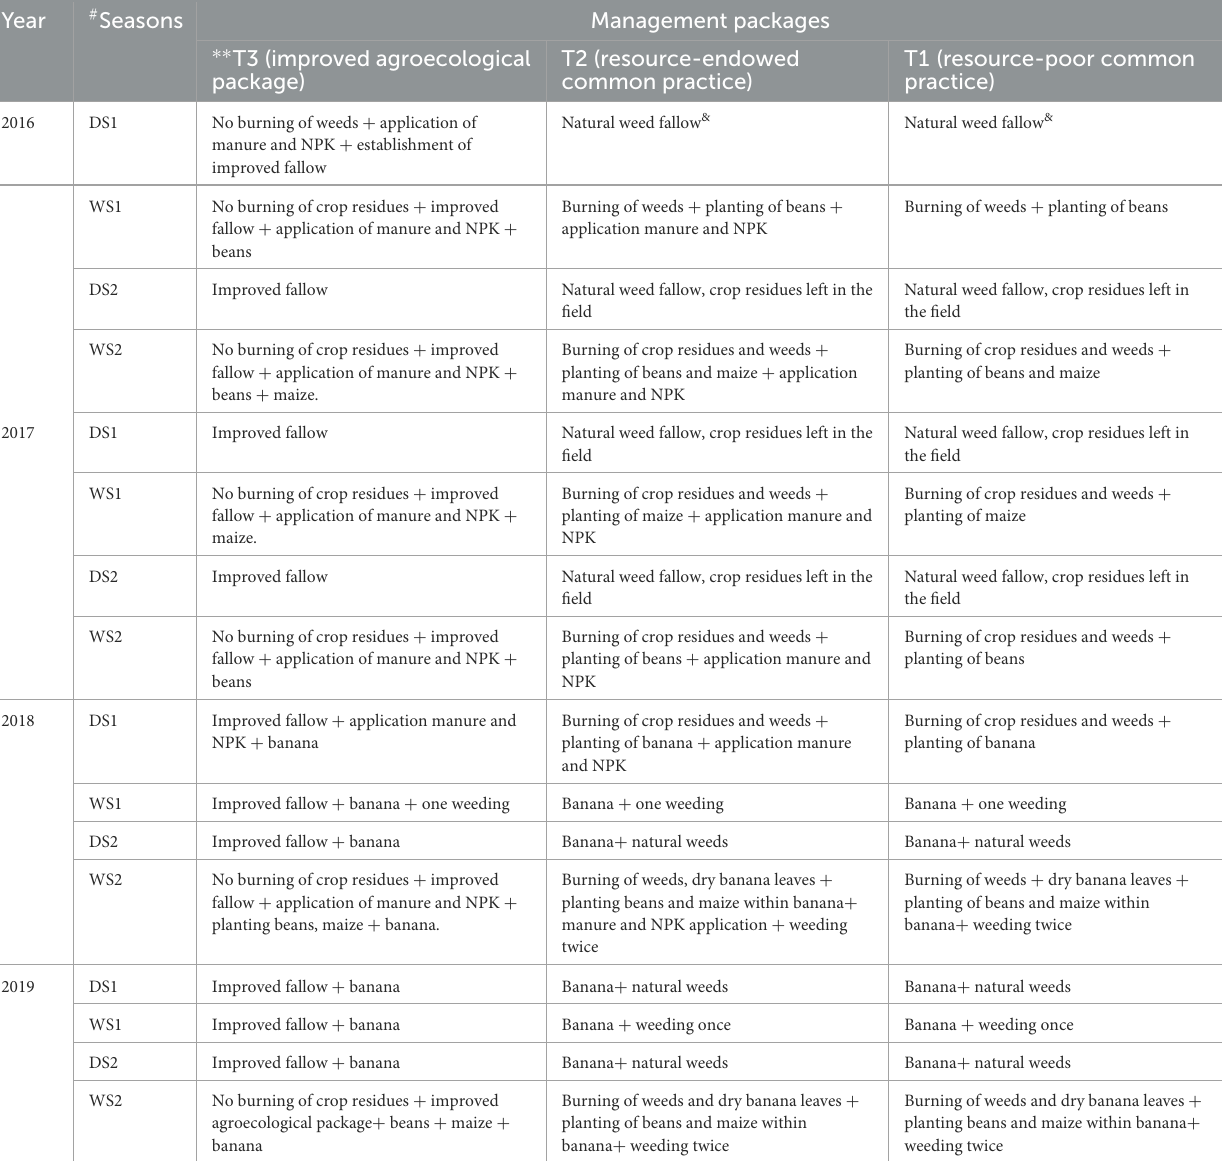
TABLE 2 Description of the management packages established over a four-year period at Mushinga and Mulungu, in South Kivu Province, Democratic Republic of